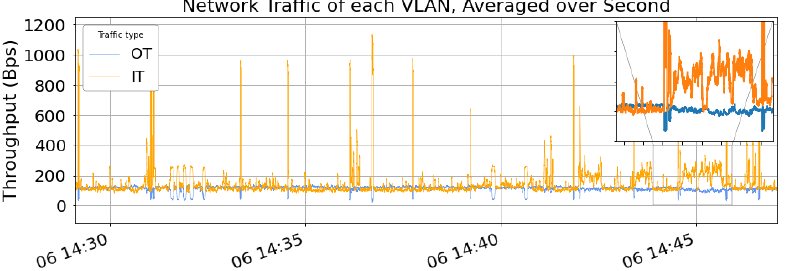
Figure 3. Data transmission dynamics in the network for Internet technology (IT) and operational technology (OT)